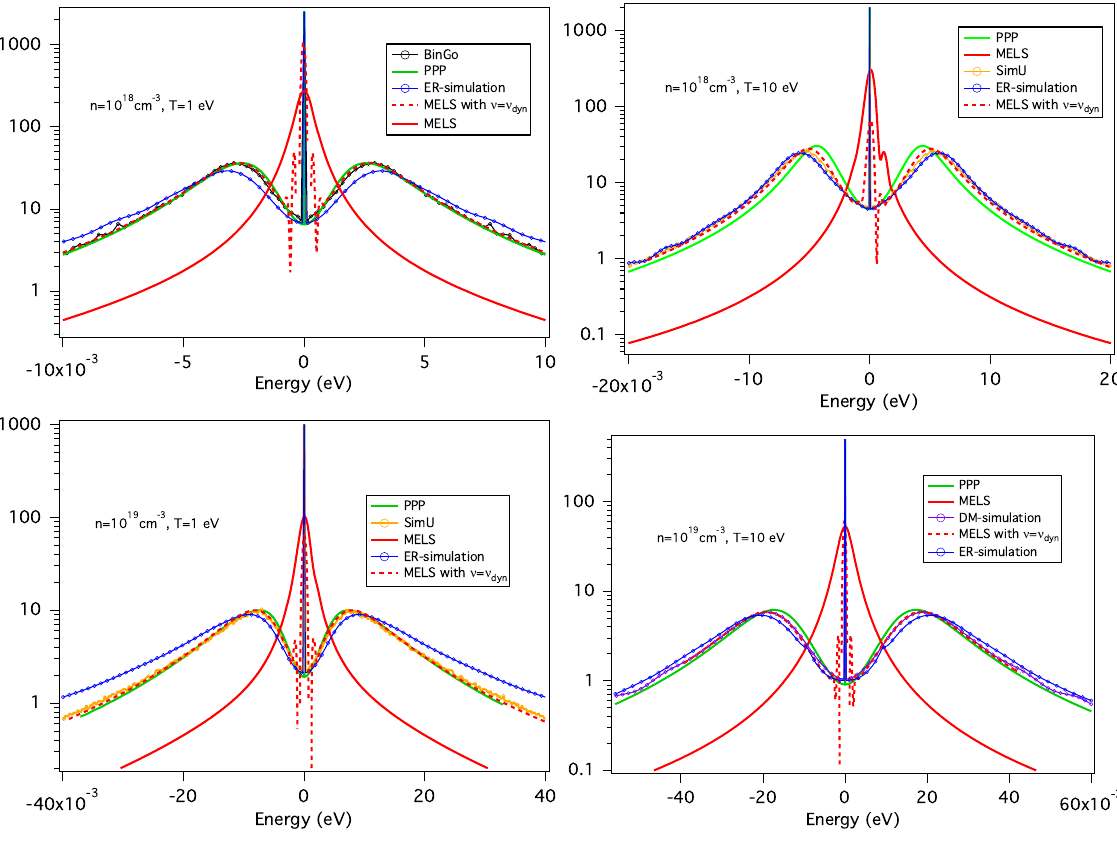
Figure 9. Spectral line shapes of the Lyman- α line in a pure vibrating field. Comparisons of the results obtained by the different